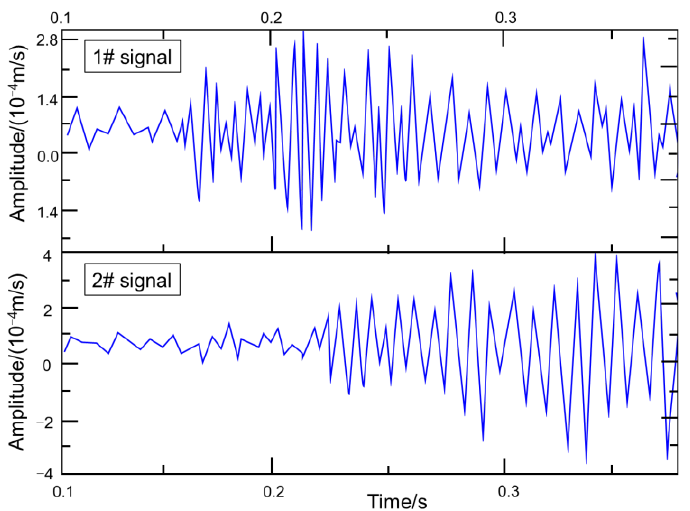
Figure 27. Micro-seismic signal of suspected water inrush channel rupture [177].